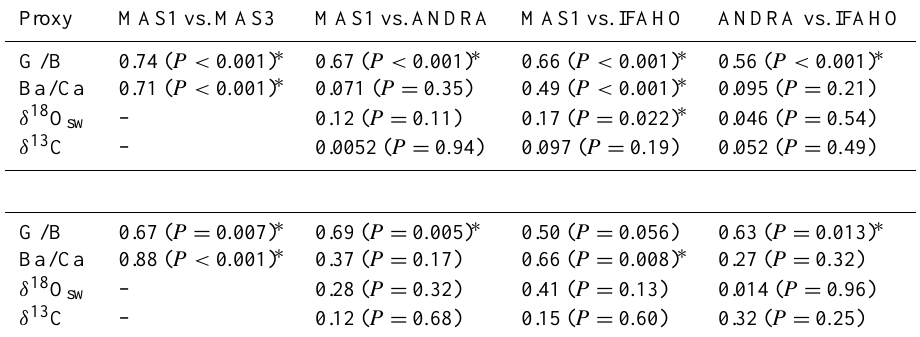
Table 2. Correlation coefficients of seasonal (upper) and annual average (lower) coral proxy data between the three coral sites MAS1, ANDRA and IFAHO, and LA-ICP-MS data for MAS1 and MAS3. Significance levels are given in parentheses, and correlation coefficients, which are below the significance level of P < 0 . 05, are marked with a star ( ∗ ). The annual average proxy values were calculated by averaging the months January to December for which the highest between core correlations were found. Proxy MAS1 vs. MAS3 MAS1 vs. ANDRA MAS1 vs. IFAHO ANDRA vs. IFAHO G/B 0.74 ( P < 0 . 001) ∗ 0.67 ( P < 0 . 001) ∗ 0.66 ( P < 0 . 001) ∗ 0.56 ( P < 0 . 001) ∗ Ba/Ca 0.71 ( P < 0 . 001)